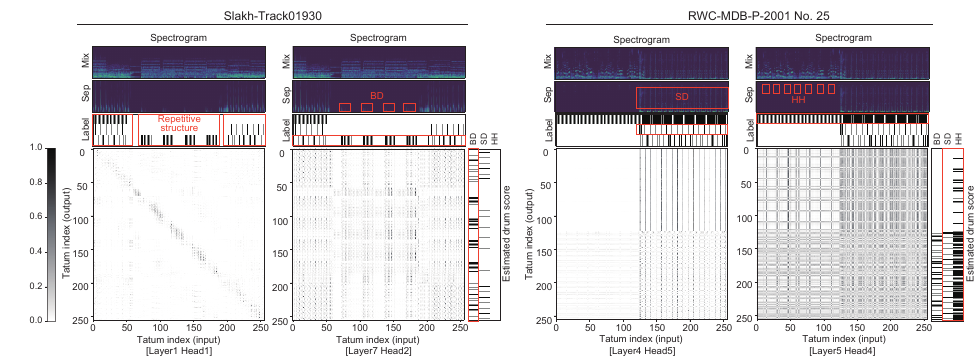
Figure 9. Examples of attention matrices representing the repetitive structures of drum scores.